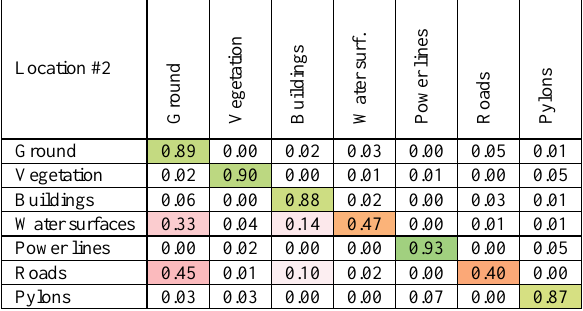
Table 4. Confusion matrix after monosource semantic segmentation of Location #2.